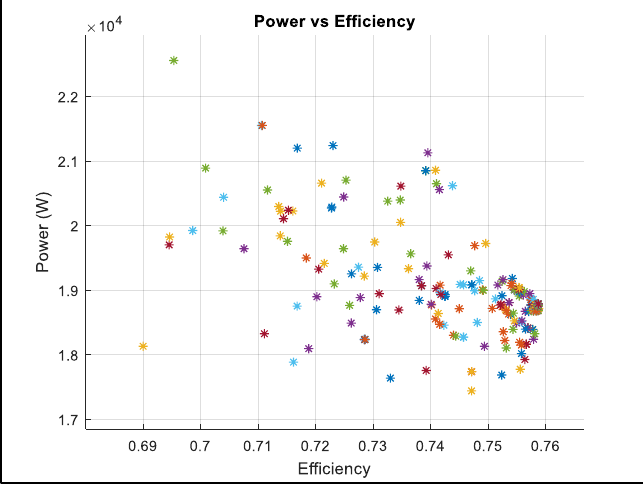
Figure 15. Power against efficiency for all assessed configurations within design objective constraints.